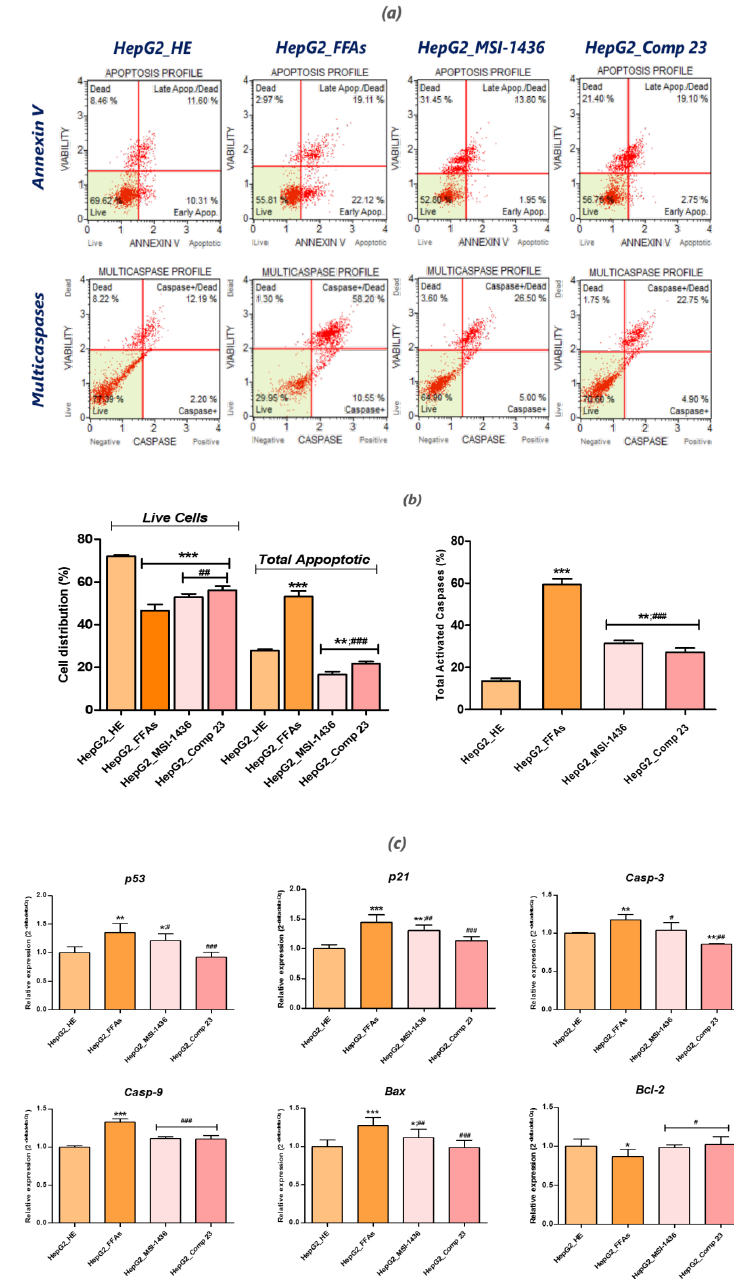
Figure 3. Evaluation of lipoapoptosis in MIS-1436 and compound 23-preconditionned or non-treated HepG2 cells following intracellular free fatty acid (FFA) accumulation. ( a ) Apoptosis and Multicaspase profile plots. Each plot is a representative figure of the three replicates of each determination. ( b ) Bar charts depicting the percentage of live and total apoptotic cells, as well as the average of the total positively activated multicaspase cells. ( c ) Representative bar charts of the relative expression of apoptotic key markers. Representative data from three independent experiments are shown as mean ± SD ( n = 3). An asterisk (*) indicates a comparison of all treated groups to untreated healthy cells. A hashtag (#) refers to a comparison of the PTP inhibitor treated groups to FFA-challenged cells. * / # p < 0.05, ** / ## p < 0.01, *** / ### p < 0.001. HepG2_HE: HepG2 healthy untreated cells; HepG2_FFAs: HepG2 cells exposed to the palmitate / oleate combination; HepG2_MSI-1436: HepG2 cells pre-treated with 1 µ M MSI-1436 inhibitor and exposed to the palmitate / oleate combination; HepG2_Comp 23: HepG2 cells pre-treated with 1 µ M compound 23 inhibitor and exposed to the palmitate / oleate